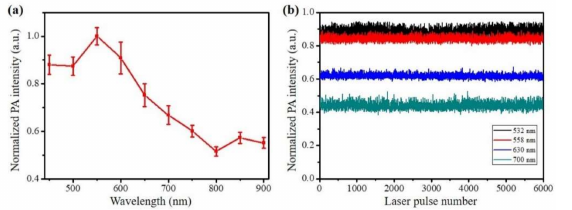
Figure 4. PA performance of the Chi-GO hemostatic sponge. ( a ) Measured PA spectra. ( b ) Photosta- bility test at indicated wavelength.